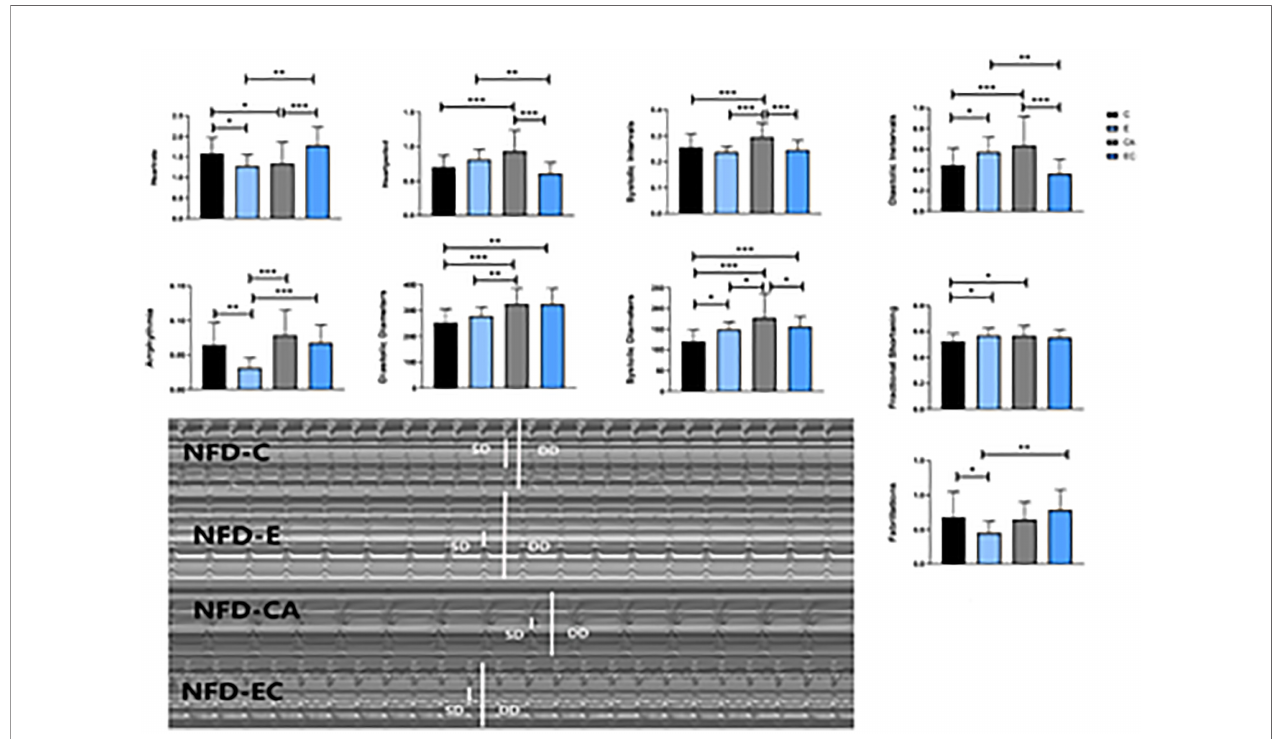
FIGURE 7 | Changes in heart function of NFD fruit fl ies. *P < 0.05, **P < 0.01, ***P <